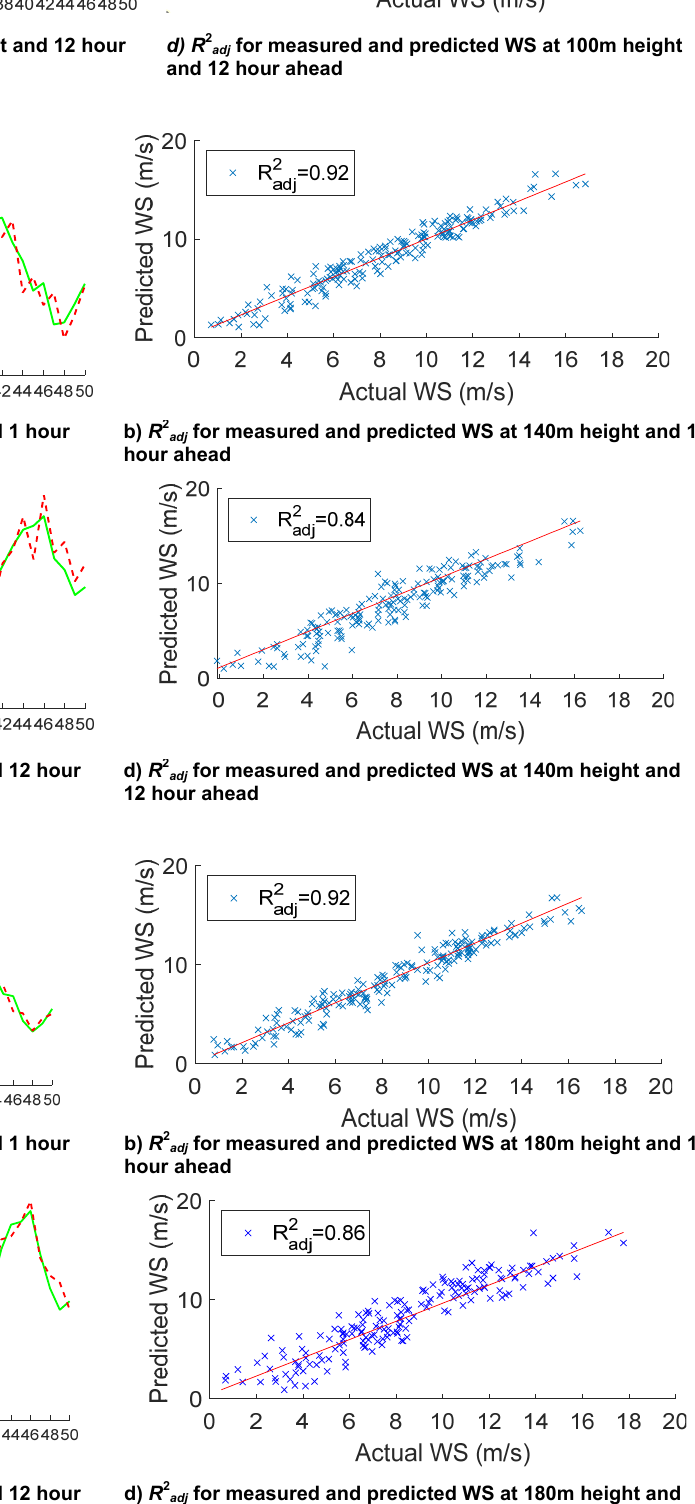
Figure 5. Performance at height